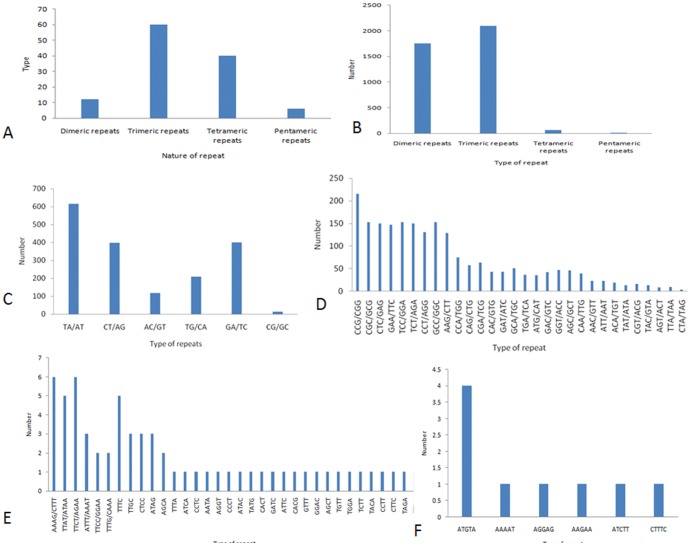
Summary of microsatellite repeats identified in the generated transcriptome.(A) Classification of microsatellites based on different types of motifs (B) Classification of microsatellites based on nucleotide string (C) Characterisation of dinucleotide repeats detected in transcripts (D) Characterisation of trinucleotide repeats detected in transcripts (E) Characterisation of tetranucleotide repeats detected in transcripts (F) Characterisation of pentanucleotide repeats detected in transcripts.